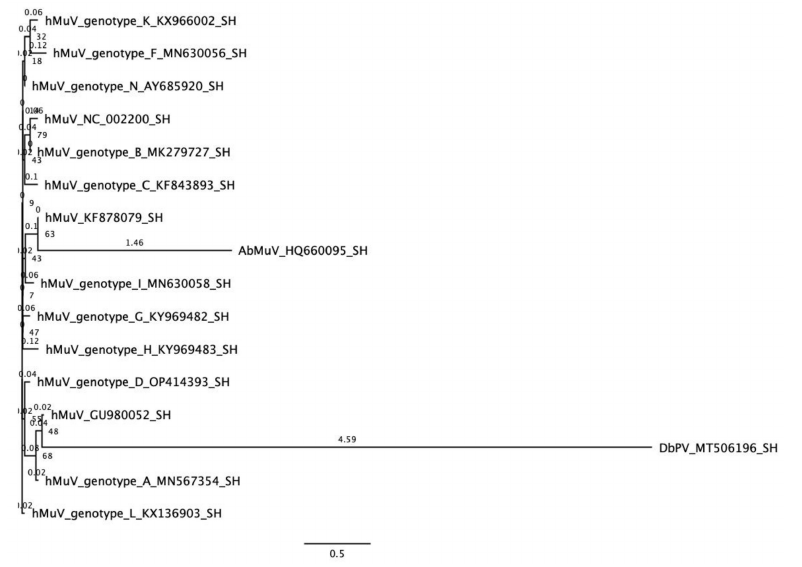
Figure 2. Maximum likelihood tree of complete SH gene product. While the nearest known neighbor to DbPV is AbMuV (HQ660095), DbPV does not cluster with AbMuV in phylogenetic analysis of the complete SH gene product. The unrooted tree is labeled with bootstrap values and branch